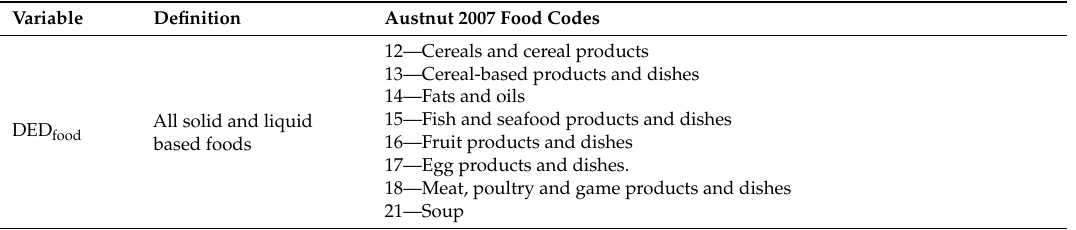
Table A1. The food groups that were included and excluded in calculating the three DED variables identified via the AUSTNUT 2007 two-digit, three-digit and five-digit food codes 1,2